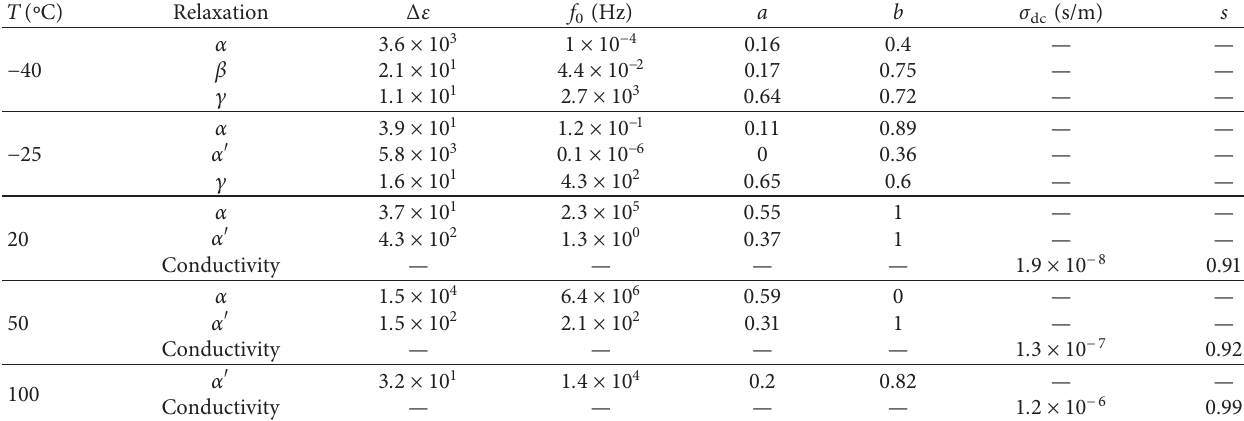
Table 3: Fitting parameters of the specific relaxation